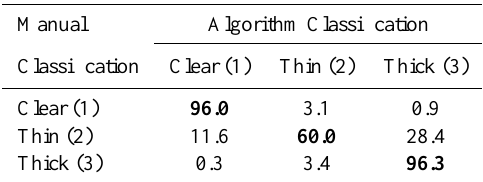
Table 5. Confusion matrix for CDOC of validation set based on the Diff HCF metric (Eq. 6). All values are in [%] and add up to 100% across